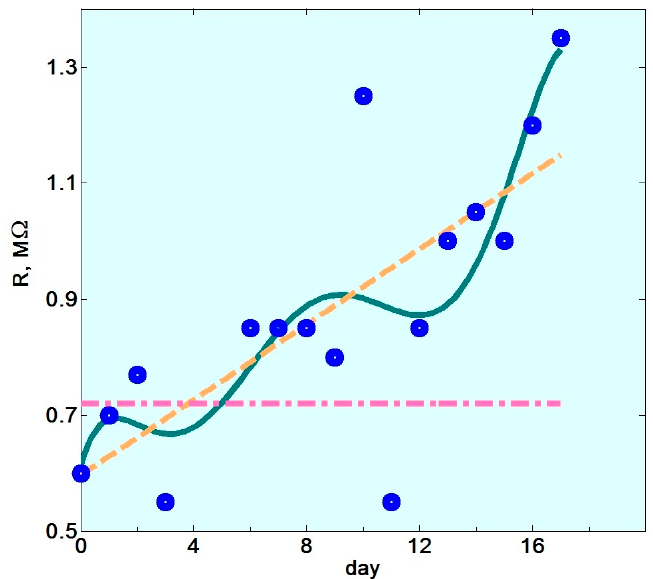
Figure 4. The time evolution of resistance of the exemplary sensor segment (#33) of the e-nose array measured in the mornings during the second measurement series (blue points) versus the day. Dashed yellow line indicates rather steep linear resistance trend. Solid green line discloses the step-like character of resistance curve under approximation by polynomial function of sixth degree. The dash-dotted red line marks the resistance level measured during the first series.